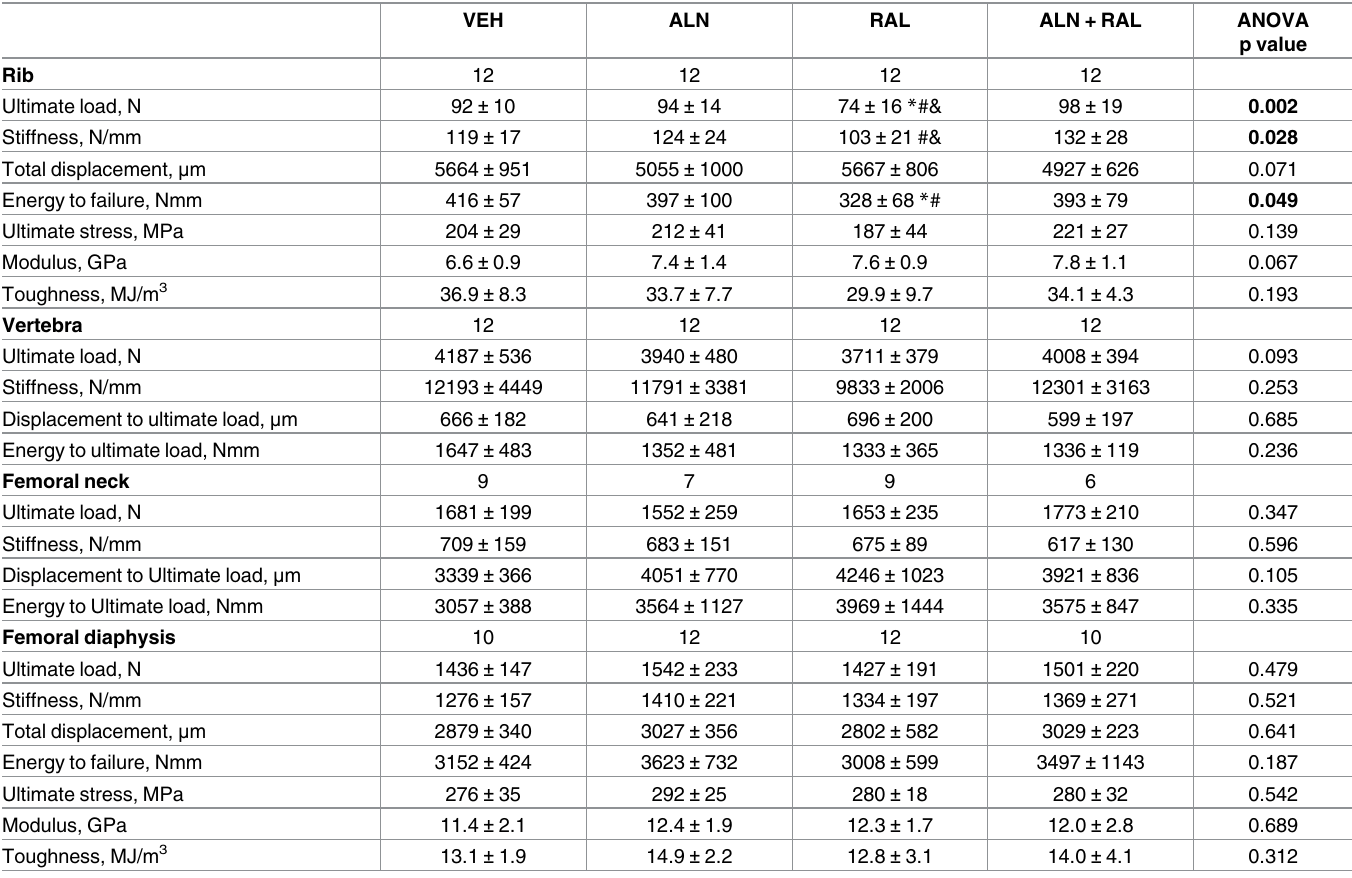
Table 5. Structural and estimated material